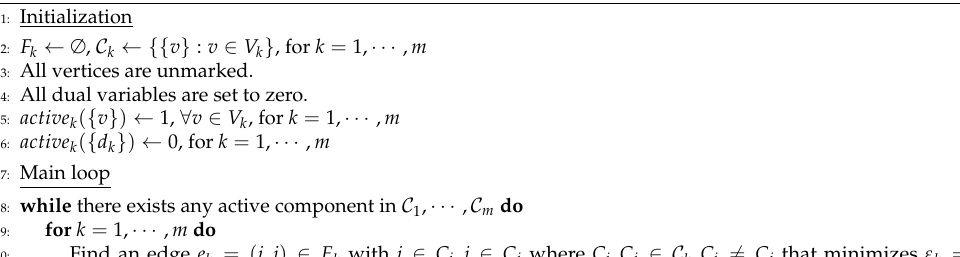
Algorithm 2 [TourCost, Tour] = GetPartition( Cost , W